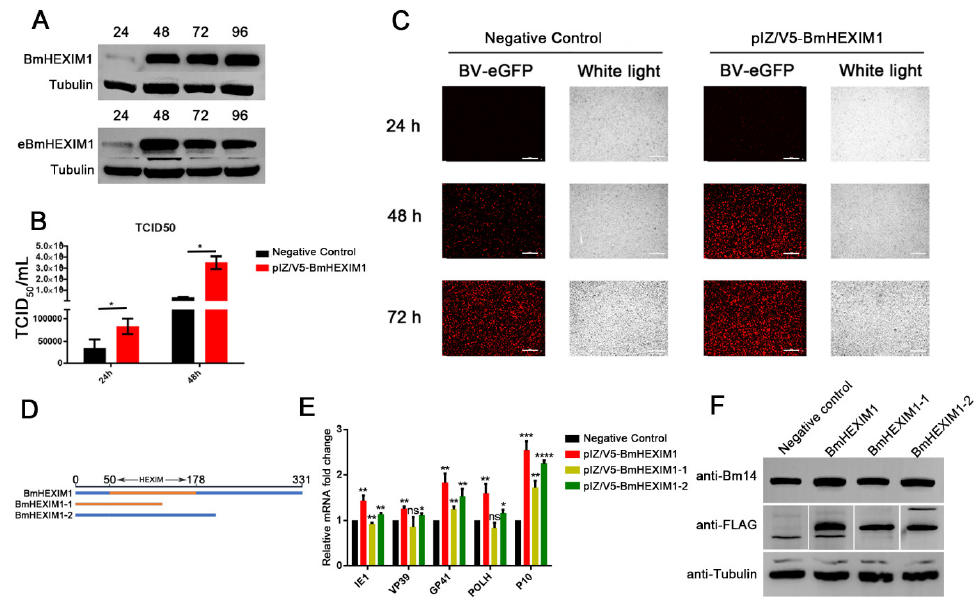
Figure 3. BmHEXIM1 promoted BmNPV proliferation, and its full length was essential to promote viral transcription. ( A ) BmN cells were transfected with pIZ/V5-BmHEXIM1 expressing plasmid, and the expression of BmHEXIM1 was analyzed by Western blot at 24 h, 48 h, 72 h, and 96 h. ( B ) TCID 50 end-point dilution was used to evaluate the production of infectious BV at 24 h and 48 h. ( C ) The infected cells (the cells with green fluorescence) were observed by an inverted fluorescence microscope at 24 h and 48 h (bar = 100 µ m). ( D ) Determination of the region of BmHEXIM1 promoted BmNPV proliferation. ( E ) BmN cells were transfected with pIZ/V5-BmHEXIM1, pIZ/V5-BmHEXIM1-1, and pIZ/V5-BmHEXIM1-2 expressing plasmid for 48 h. Then, the cells were infected with BmNPV for 48 h. The viral gene’s expression was measured by qRT-PCR analysis. ( F ) BmNPV abundance was assessed by analyzing the expression levels of Bm14 by Western blot. The mRNA level of target genes was normalized to the internal control (BmRPL32). Data represent mean ± SEM of the three independent experiments. The number of asterisks represents the degree of significance with respect to p -value. p -values were provided as * p < 0.05; ** p < 0.01; *** p < 0.001; **** p <